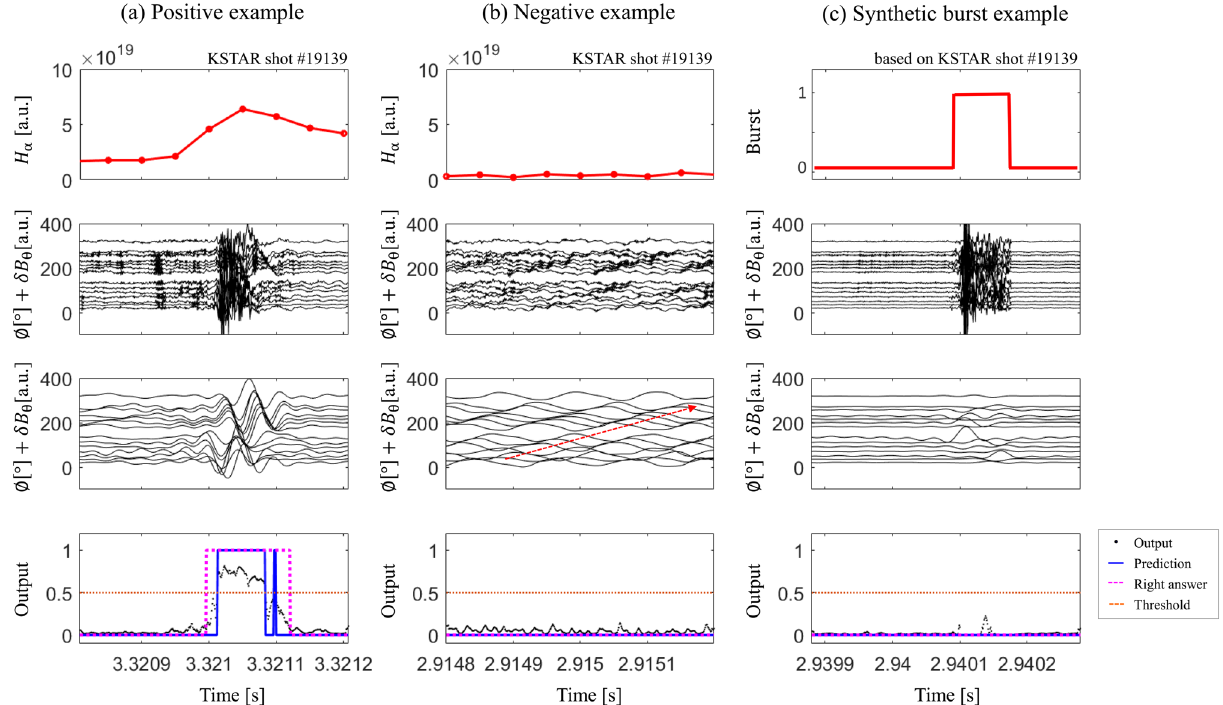
Figure 2. Representative test results of the final ML model. The first row is the H α signal, the second row is the raw MC signals the third row is the band-pass filtered MC signal, and the last row is the output probability of the final model for ( a ) positive example, ( b ) negative example, and ( c ) synthetic burst example. Here, the first row in the synthetic burst example represents the burst period used to create the synthetic burst data instead of H α signal. The black dot, blue line, magenta dotted line and orange dotted line in the last row respectively indicate output probability, prediction of SP existence, right answer of SP occurrence and the threshold of output to determine the presence or absence of SP. The ELM signal during the inter-burst period is shown in the filtered MC data in ( b ). The red dashed arrow indicates the toroidal flow direction of the